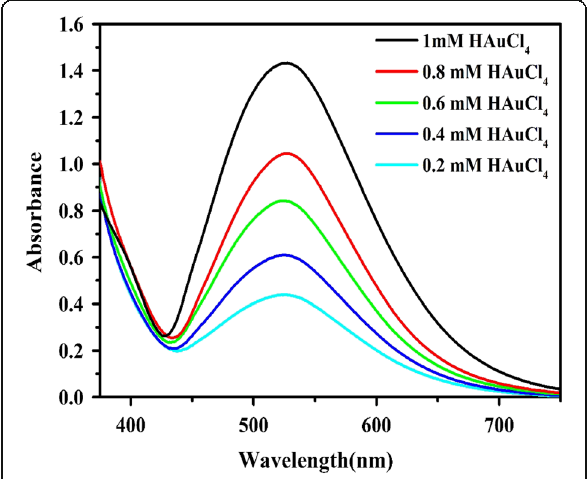
Fig. 2 The UV-vis absorption spectra of AuNPs synthesized by using different concentrations of HAuCl 4 and 1% papaya leaf extract